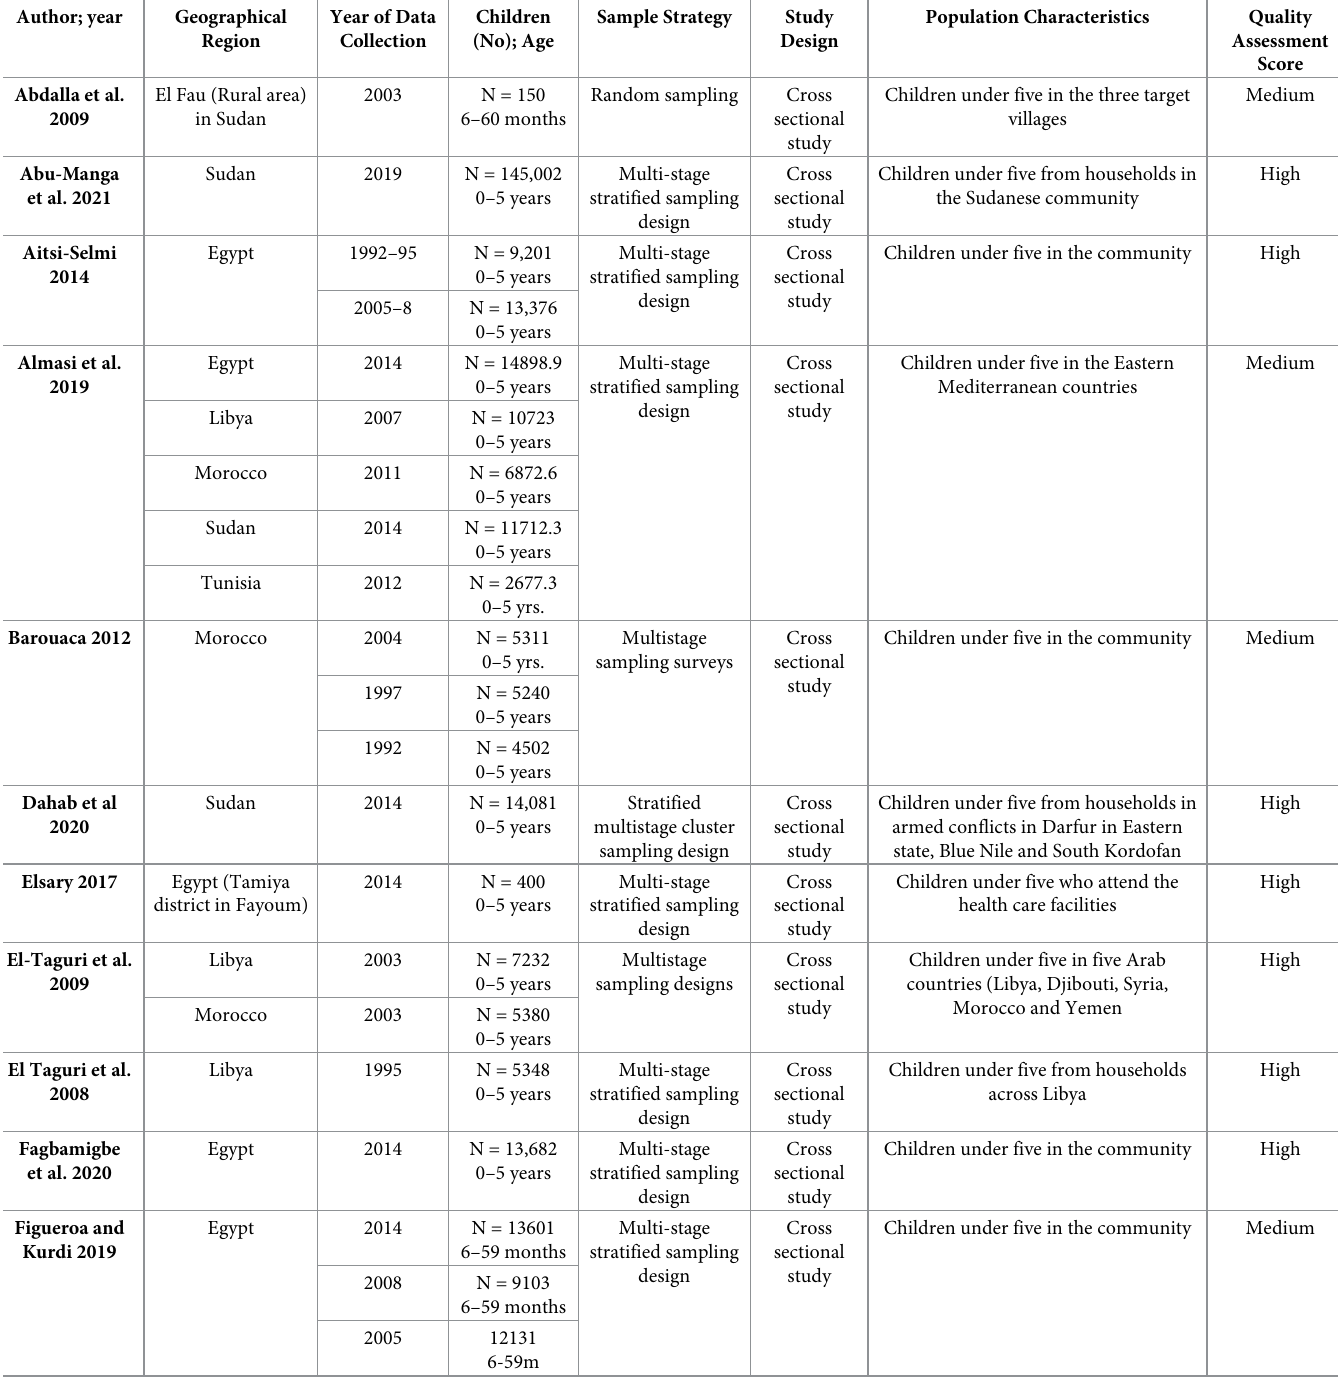
Table 1. Characteristics of included publications in the